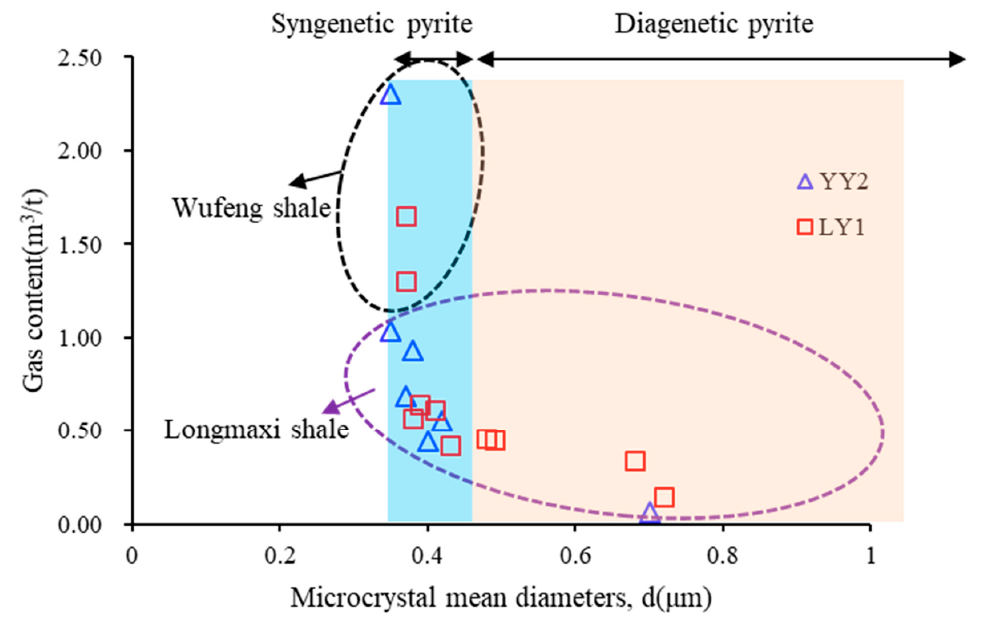
Figure 9. ( a ) Relationship between gas content and TOC values; ( b ) relationship between gas content and pyrite content for 17 shale samples from well YY2 and well LY1 in the middle Yangtze area, South China.